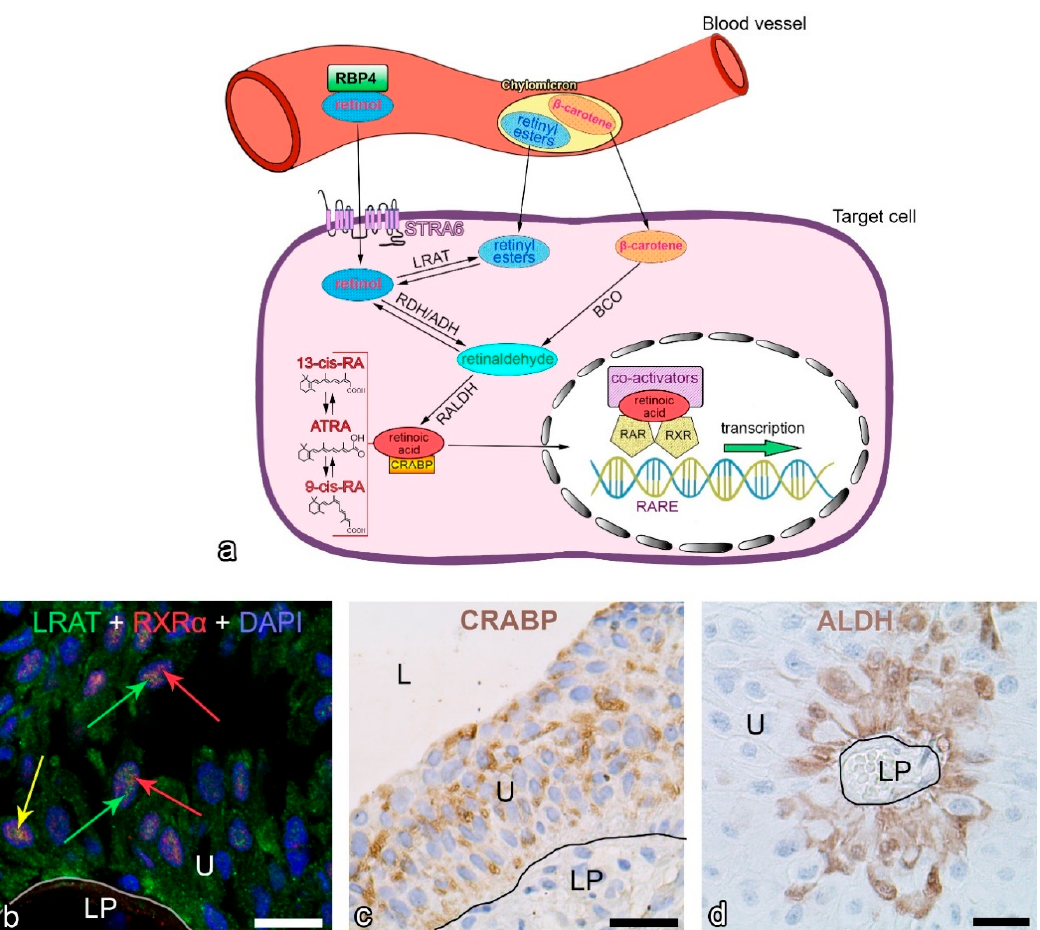
Figure 1. Molecular pathways of vitamin A in the typical human cell ( a ). Immunofluorescence of LRAT and RXR α ( b ) and immunohistochemistry of CRABP ( c ) and ALDH ( d ) in human urothelial cells from biopsy samples of papillary urothelial neoplasms of low malignant potential (PUNLMP). ( b ) LRAT (green) is labelled mainly in the cytoplasm of urothelial cells, while RXR α (red, red arrows) is labelled exclusively in the nuclei of urothelial cells. Some LRAT labelling is detected in the nuclei of urothelial cells (green arrows). The yellow arrow shows co ‐ localization between LRAT and RXR α , which occurs rarely. The nuclei are stained blue with DAPI. ( c ) CRABP (brown) is labelled in the cytoplasm of urothelial cells of all cell layers, whereas ( d ) ALDH (brown) is labelled predominantly in urothelial cells near the basal lamina (black line). Cell nuclei are stained blue with haematoxylin. ADH, alcohol dehydrogenase; ALDH, aldehyde dehydrogenase; ATRA, all ‐ trans retinoic acid; BCO, β‐ carotene oxygenase; CRABP, cellular retinoic acid ‐ binding protein; DAPI, 4 ′ ,6 ‐ diamidino ‐ 2 ′‐ phenylindole dihydrochloride; L, lumen of bladder; LP, lamina propria; LRAT, lecithin retinol acyltransferase; RA, ret ‐ inoic acid; RALDH, retinal dehydrogenase; RAR, retinoic acid receptor; RARE, RA response element; RBP4, retinol ‐ bind ‐ ing protein 4; RDH, retinol dehydrogenase; RXR, retinoid X receptor; STRA6, stimulated by retinoic acid 6; U, urothelium; white or black line, basal lamina. Scale bars: 20 μ m ( b ), 50 μ m ( c – d ).